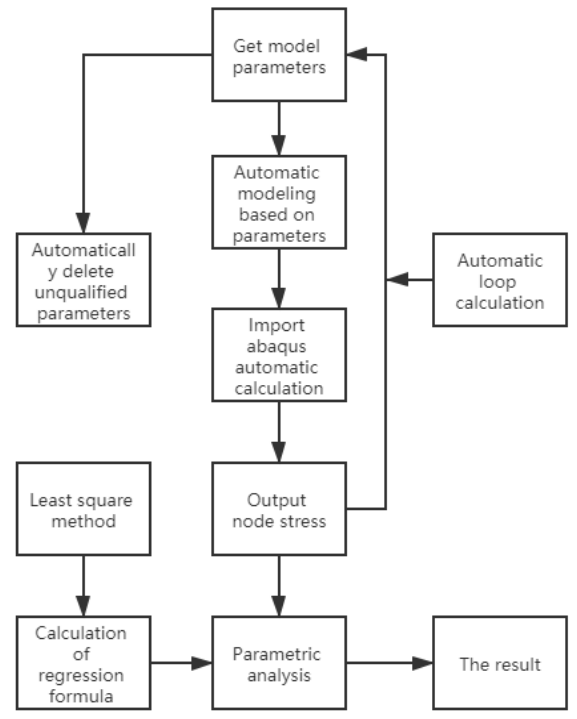
Figure 23. Analysis flow chart.